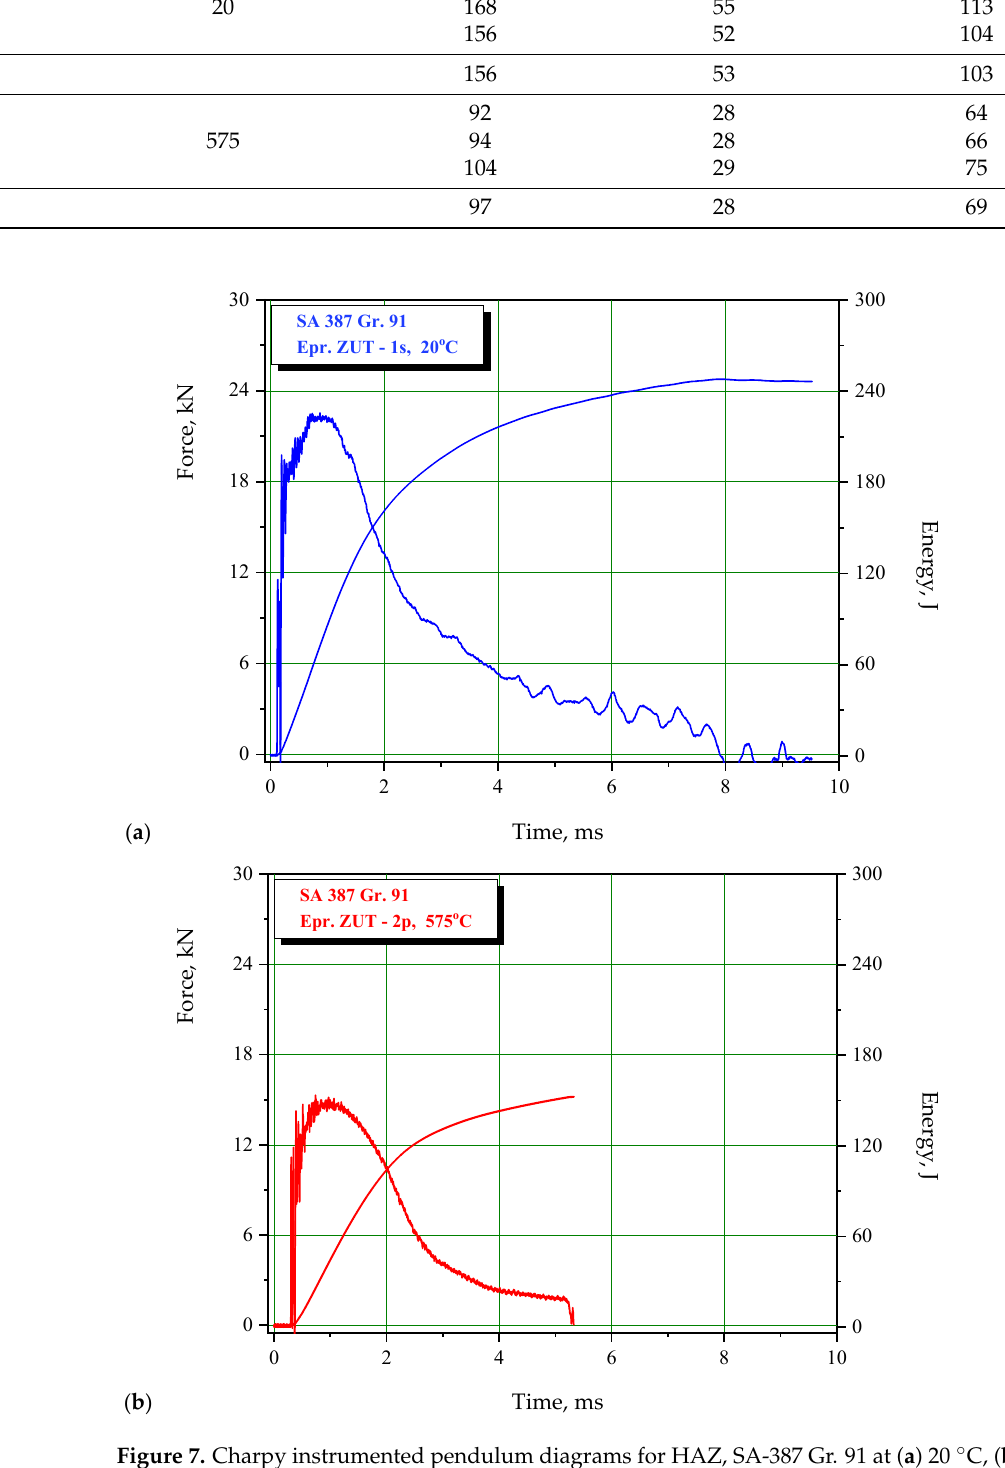
Figure 7. Charpy instrumented pendulum diagrams for HAZ, SA ‐ 387 Gr. 91 at ( a ) 20 °C, ( b ) 575 °C.